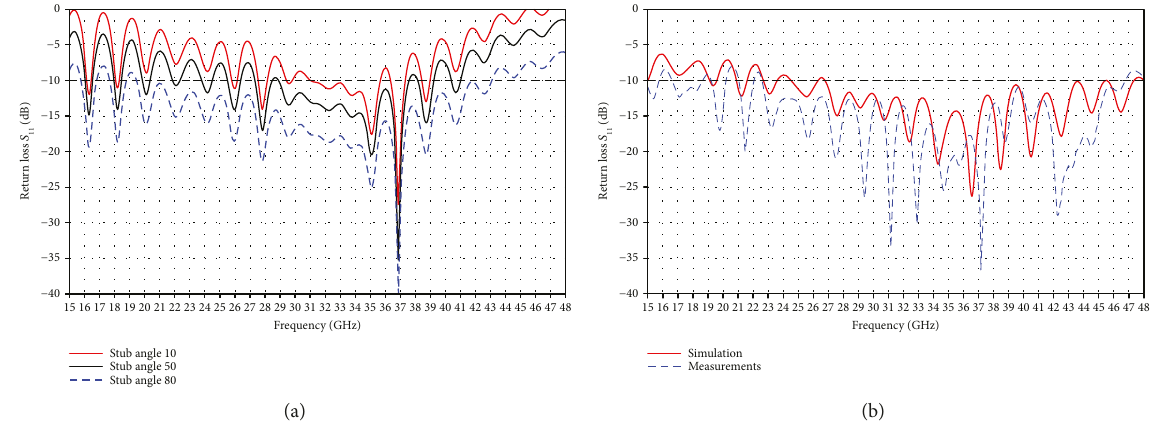
Figure 2: (a) Stub angle optimization. (b) Simulation and measured S